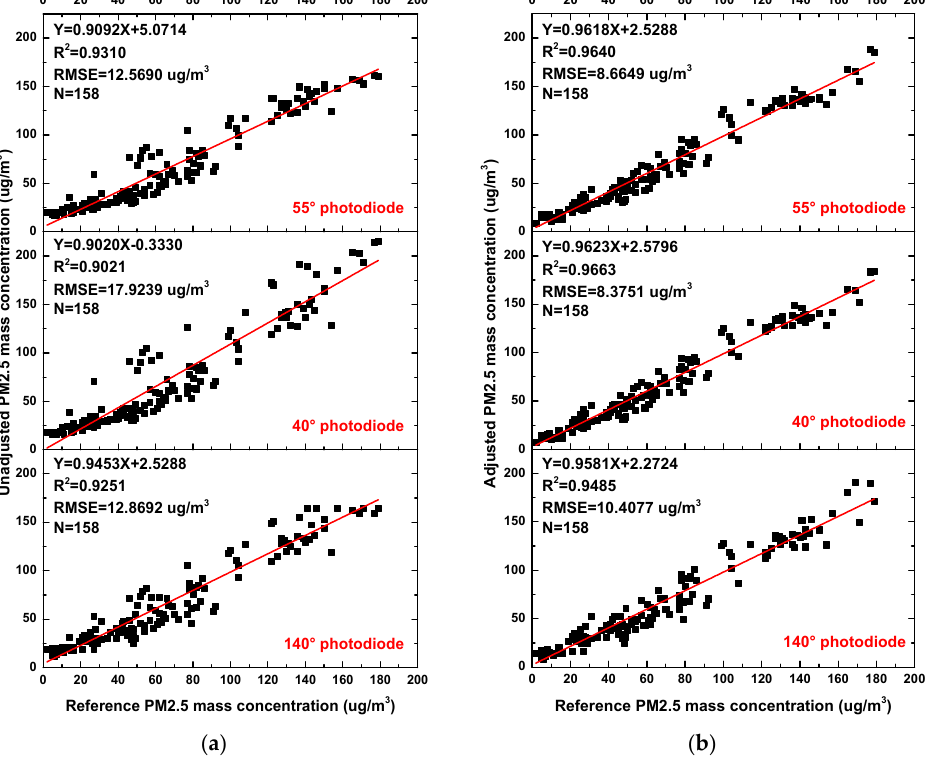
Figure 13. Scatter plot of the 1-h average PM2.5 mass concentrations using the reference Tapered Element Oscillating Microbalance (TEOM) 1405-D monitor at Wolongqiao monitoring station vs. PM2.5 mass concentrations based on three angular photodiodes in the particle sensor: ( a ) unadjusted; ( b ) adjusted.